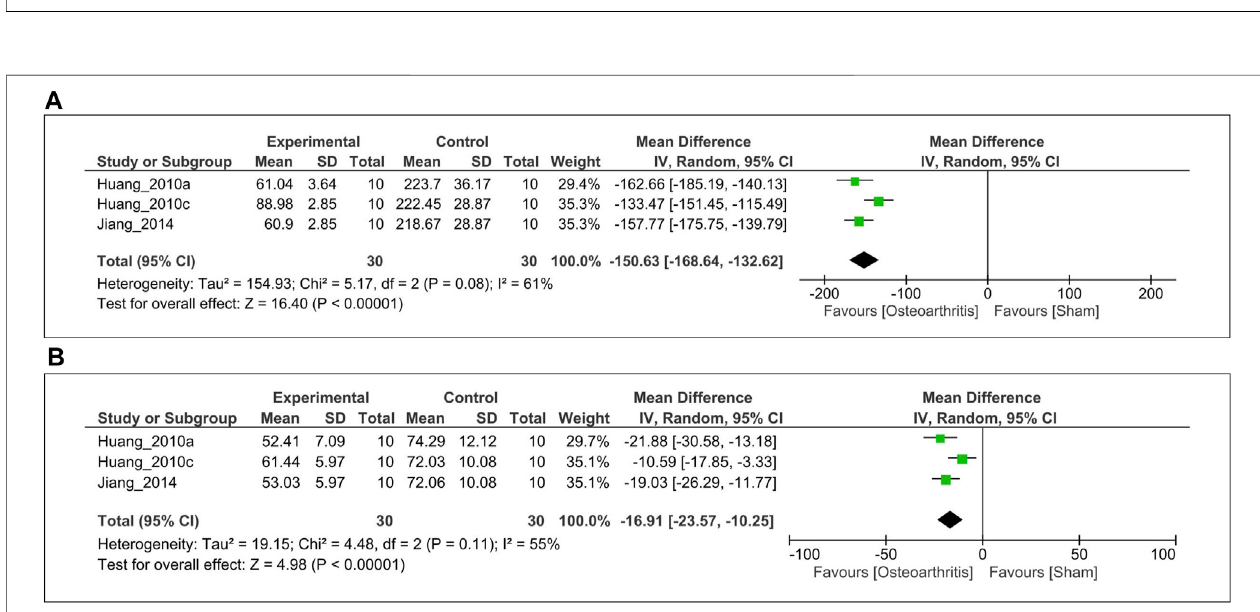
FIGURE 5 | Forest plot showing that MT treatment improved the histological score in OA models. Mankin grading score was used to assess the histological score almost all studies, except Zhang et al. (OARSI scores). OA, osteoarthritis; OARSI, osteoarthritis research society international; I, heterogeneity; CI, con fi dence interval; SD, standard deviation; IV, independent variable.